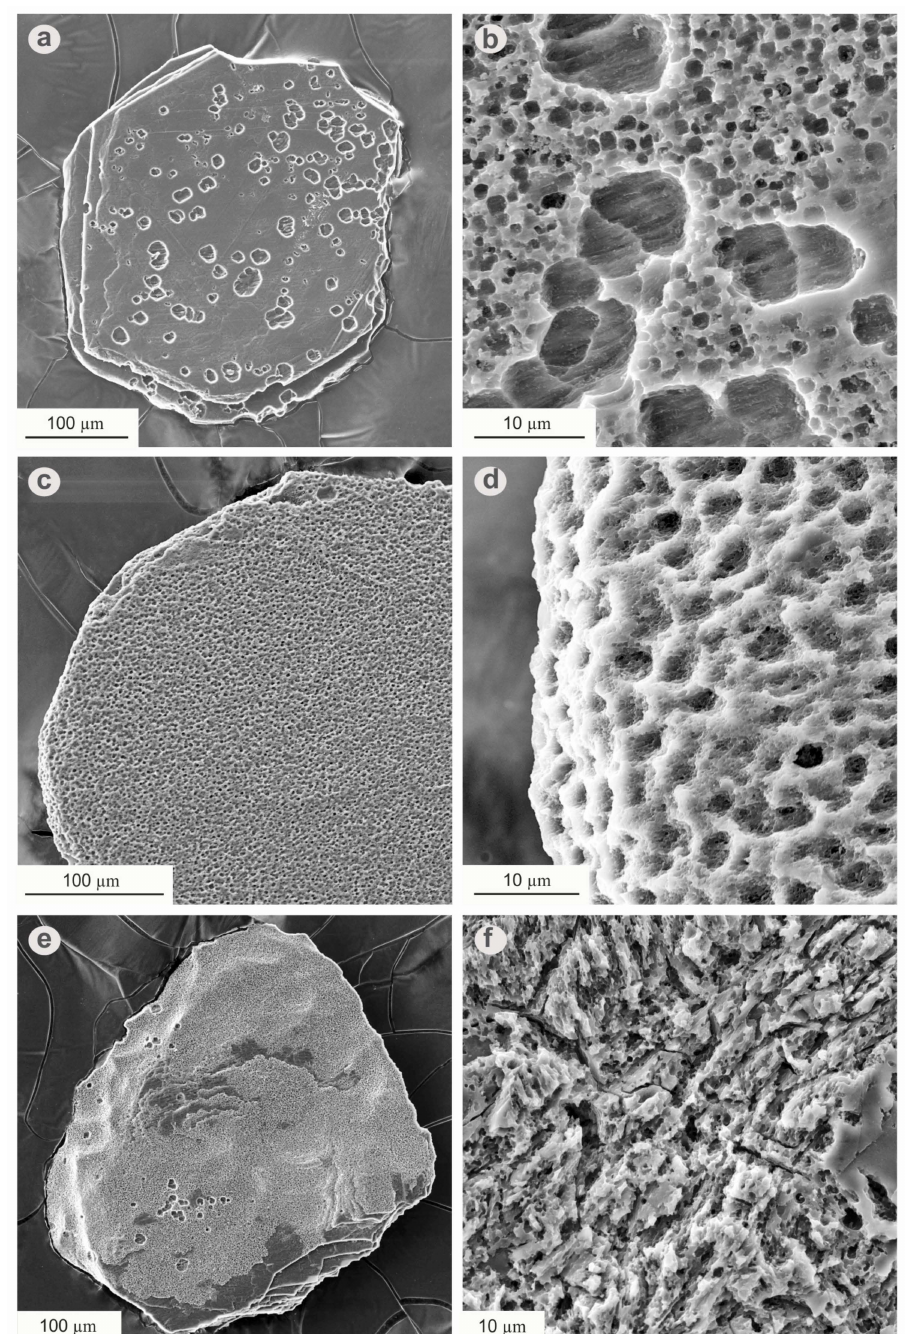
Figure 1. Pitted-honeycomb surfaces of the Popigai impact